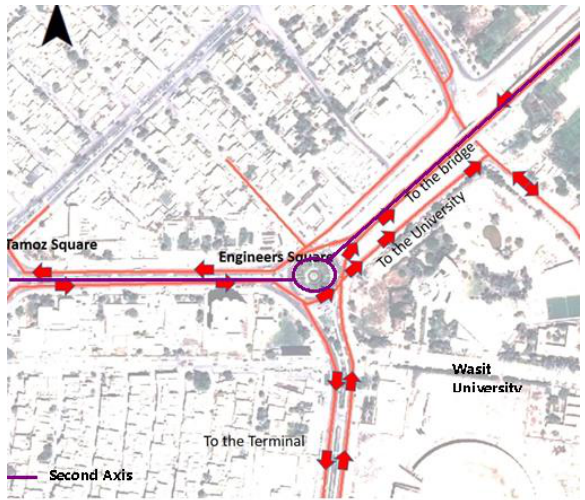
Fig. 7. The biggest congestion node in the city on the first movement